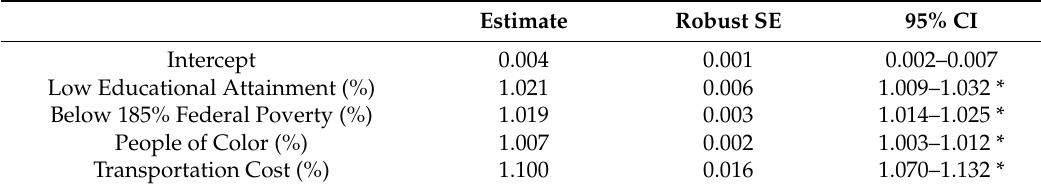
Table 2. Results of multivariate model of COVID-19 test positivity based on socioeconomic status (SES) and people of color variables. Estimates and 95% CIs are the exponentiated coe ffi cients of the Poisson model, with statistically significant associations indicated with an